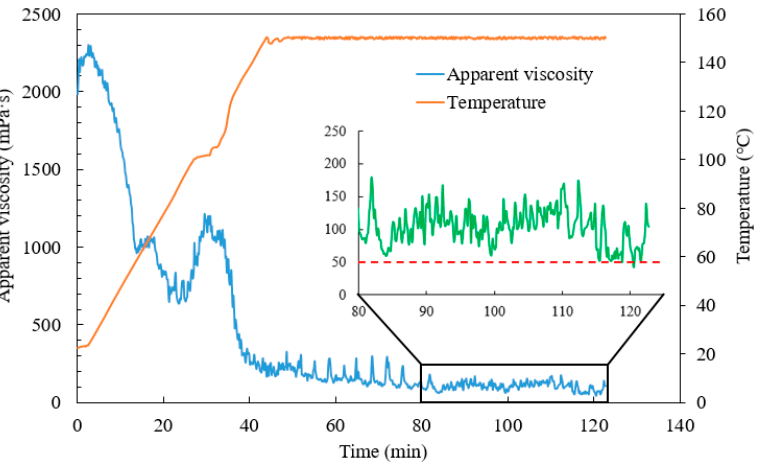
Figure 9. The rheological curve of the apparent viscosity varied with the